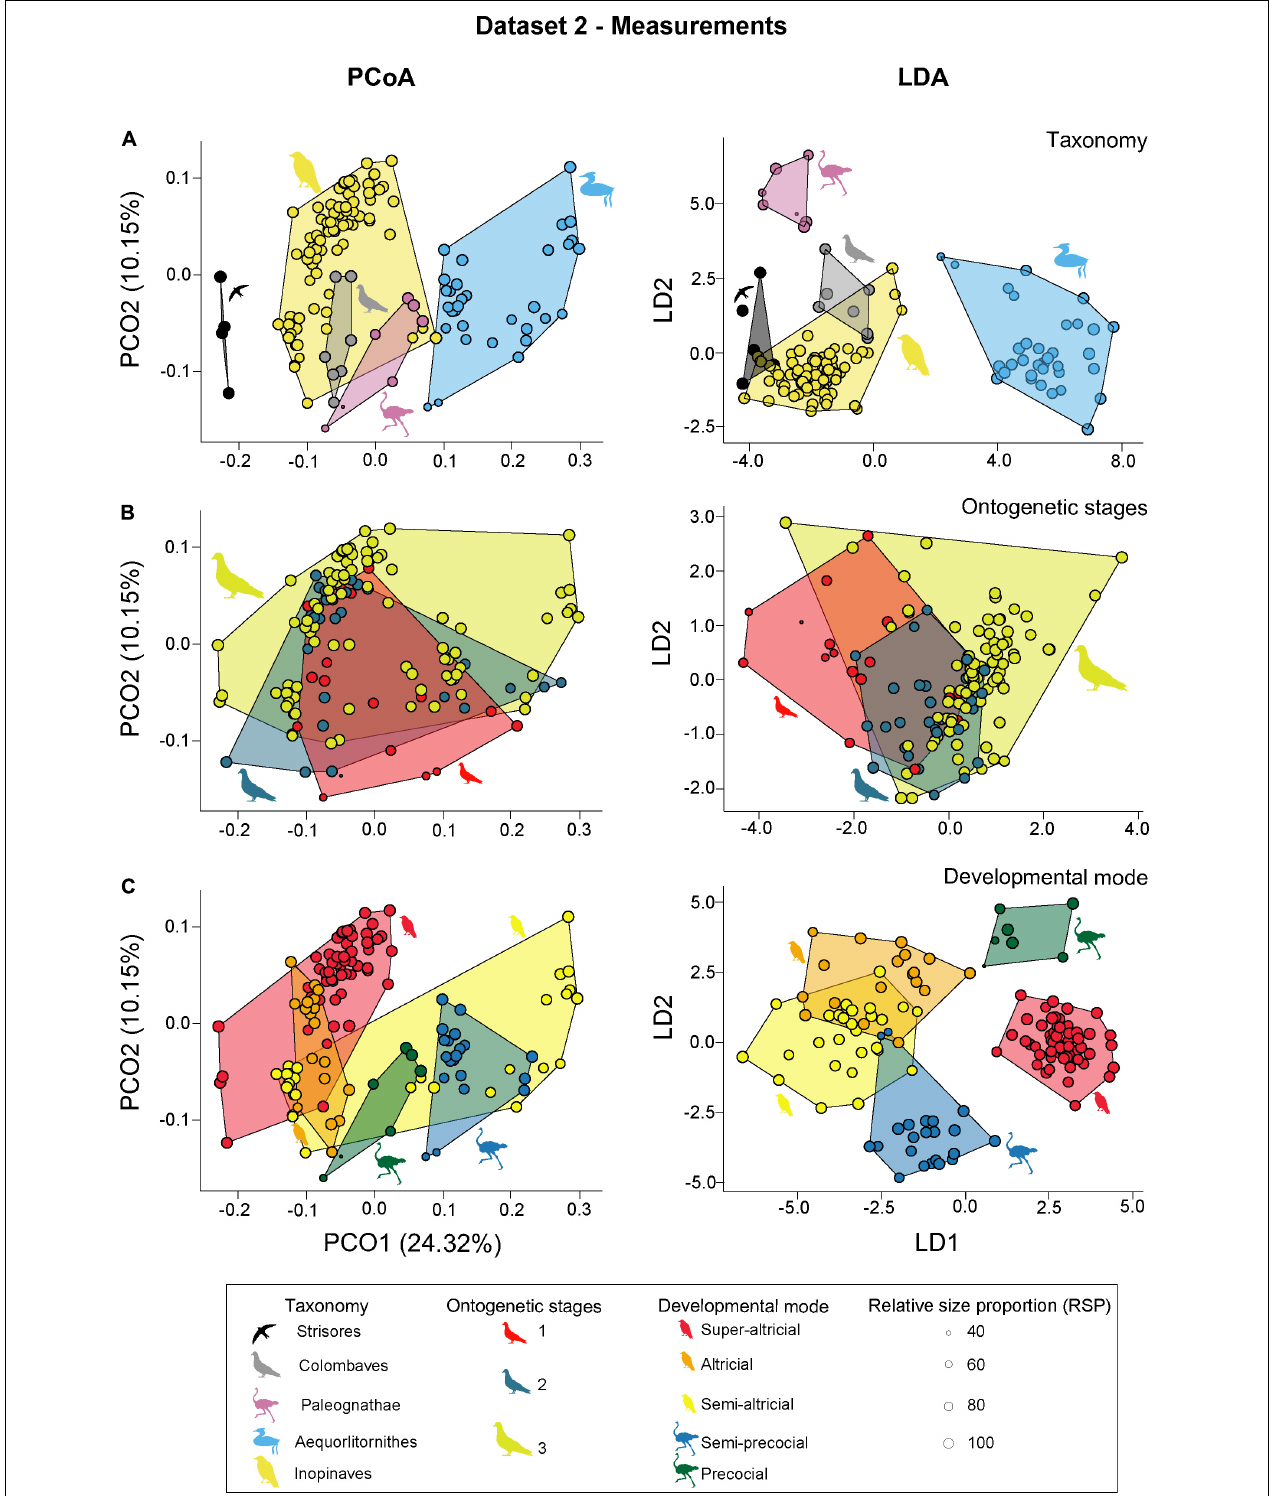
FIGURE 5 | PCoA (principal coordinate analysis) and LDA (linear discriminant analysis) results of dataset 2. (A) PCoA and LDA results showing the taxonomic morphospaces. (B) PCoA and LDA results showing the ontogenetic morphospaces. (C) PCoA and LDA results showing the morphospaces of the developmental modes. All silhouettes are taken from